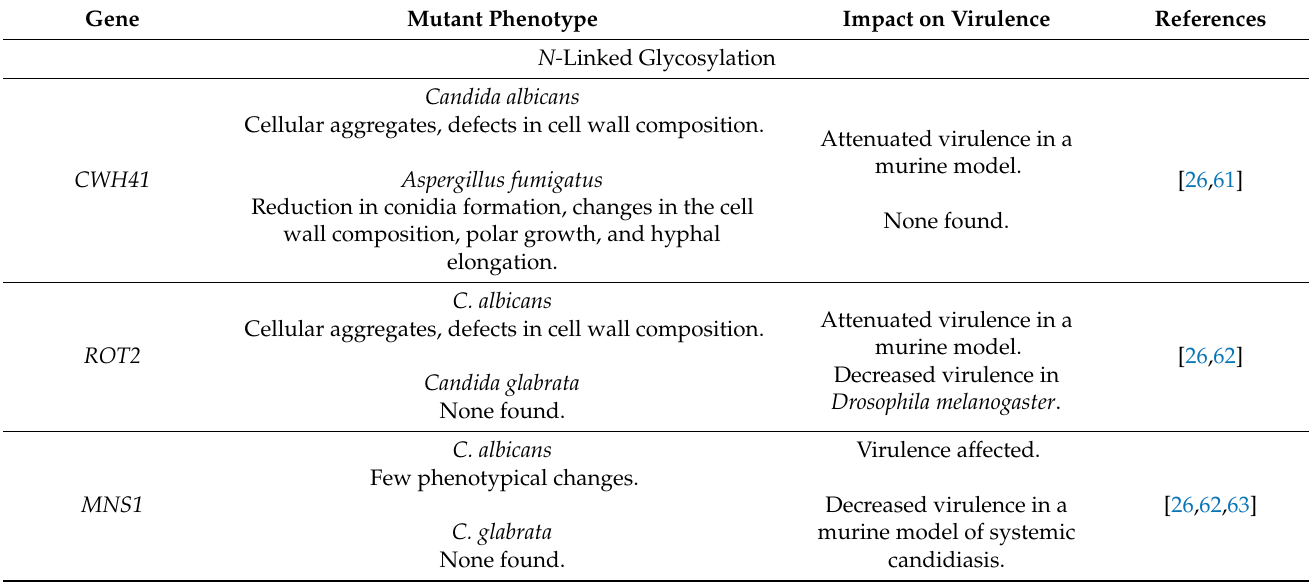
Table 1. Phenotype of mutant strains in genes involved in N -linked or O -linked glycosylation, glycosylphosphatidylinositol anchor synthesis, and non-conventional glycosylation processes, in medically relevant fungal species.